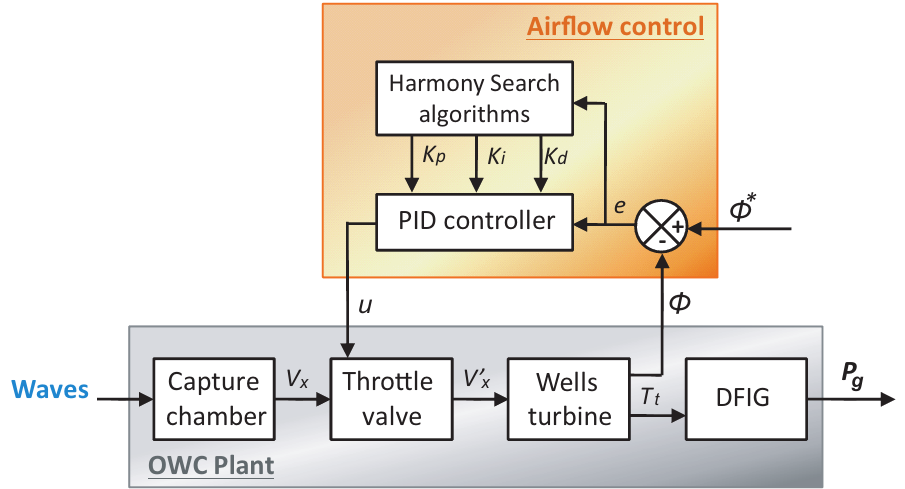
Figure 6. Airflow-control strategy for Wells-turbine-based OWC using Harmony Search